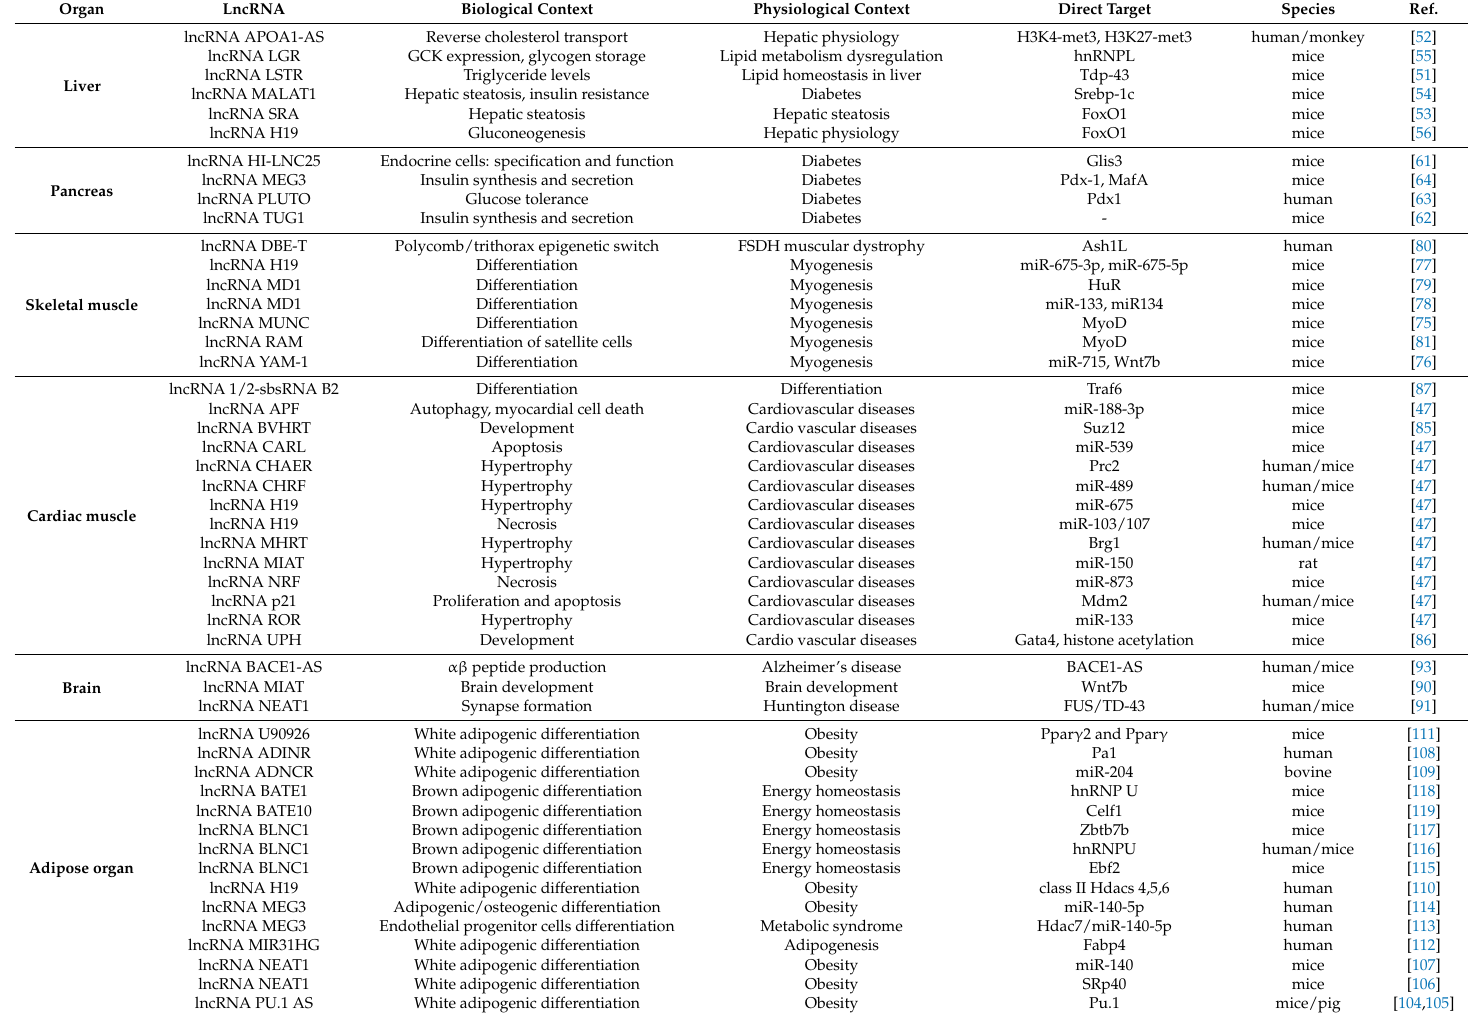
Table 1. Long non-coding RNAs (lncRNAs) in metabolic organs.